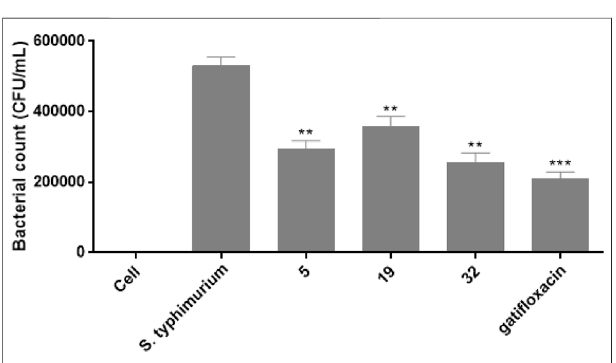
FIGURE 6 | The effects of compounds 5, 19, 32, and gati fl oxacin on the survival of S. typhimurium in RAW 264.7